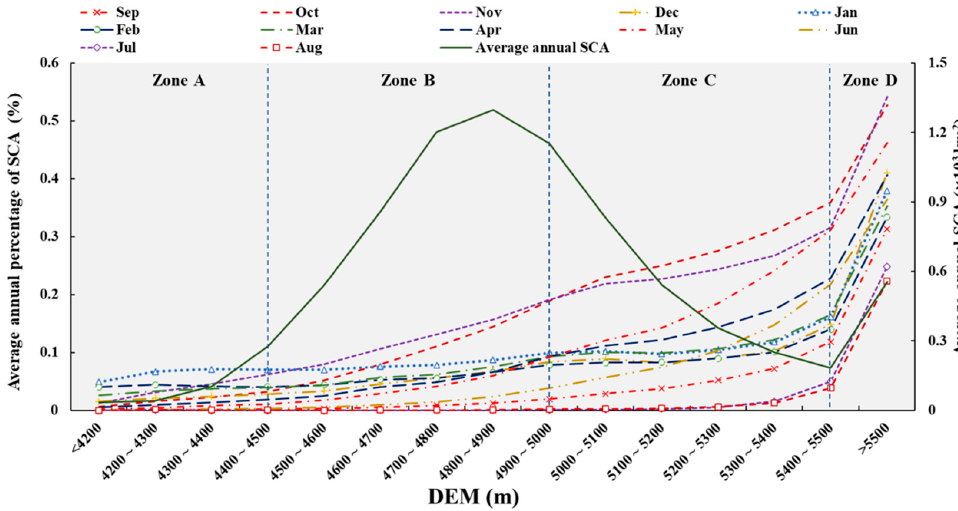
Figure 3. Vertical distribution of monthly average SCA from 2000–2019. Based on the four different elevation zones, the daily SCA of different elevation zones in the SRYR in 19 hydrological years was extracted in this paper, and the interan- nual variation of SCA of the four elevation zones was plotted (Figure 4). Among them, the SCA is the ratio of the total number of pixels under snow cover to the total number of pixels in the elevation area, and the SCA is the average of 19 hydrological years.